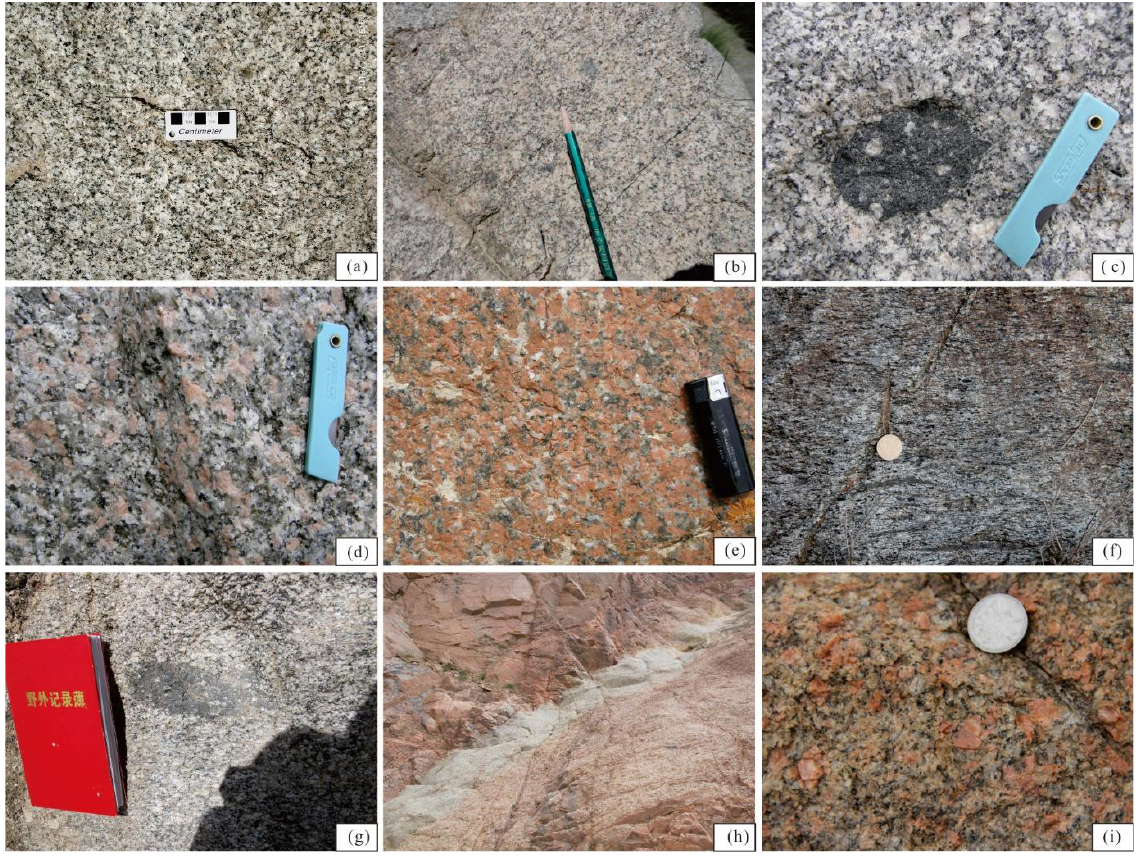
Figure 2. Outcrop photos for the Indosinian granite in the eastern region of the EKO. ( a ) Xiangjiananshan granodiorite; ( b ) Xiangjiananshan monzogranite; ( c ) Wutuo granodiorite; ( d ) Wutuo monzogranite; ( e ) Wutuo syenogranite; ( f ) Qushiang gneissic granodiorite; ( g ) Chaohuolutaogai granodiorite; ( h ) Chahantaolegai syenogranite; ( i ) Keri syenogranite.